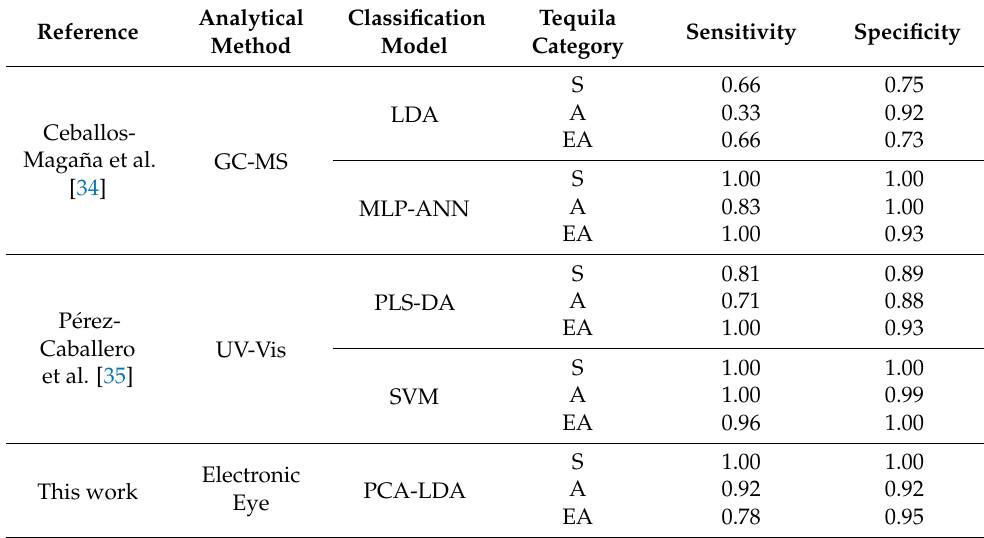
Table 4. Comparison of the current study with representative publications dealing with tequila identification (S = Silver, A = Aged and EA = Extra-aged